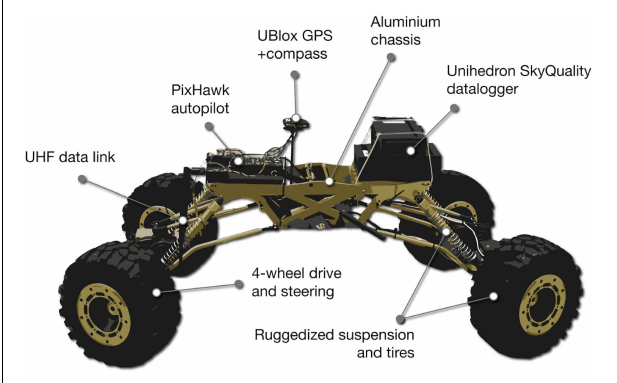
FIGURE 2 | Autonomous terrestrial rover platform (84 cm × 43.6 cm × 35 cm) equipped with continuously datalogging Unihedron Sky Quality Meters. Command and control components